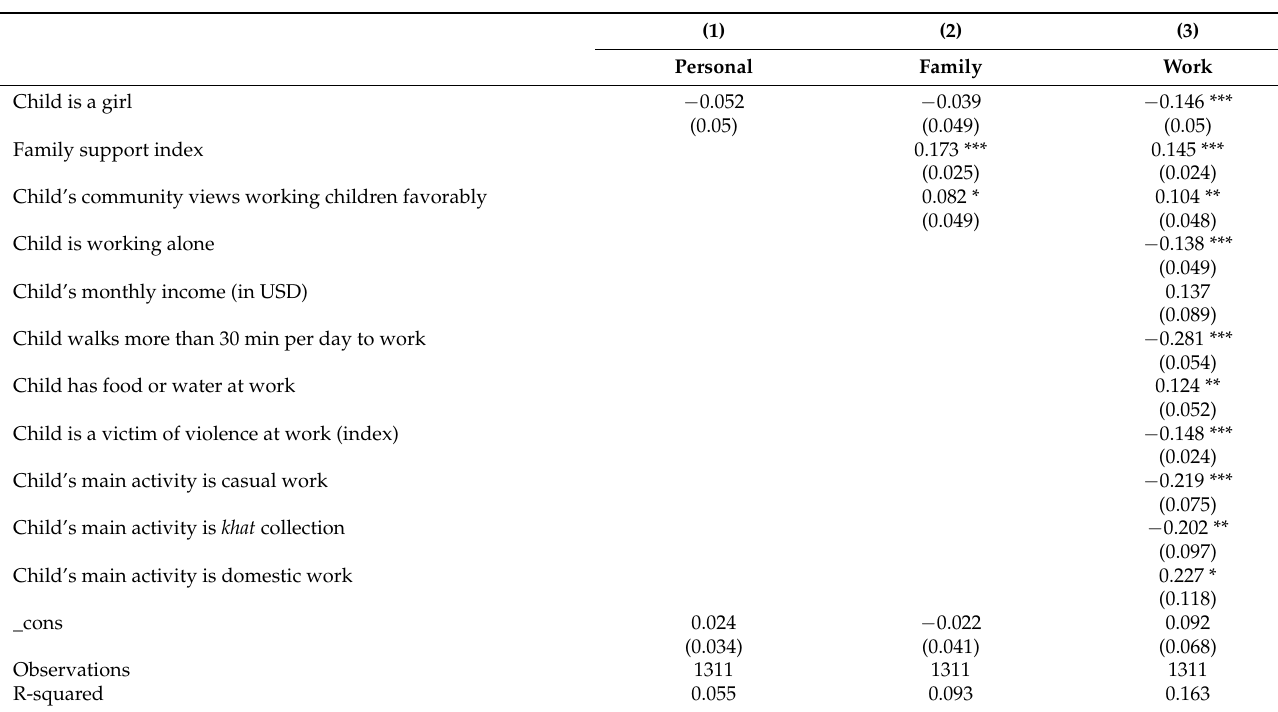
Table A6. Linear regressions for self-esteem factor.